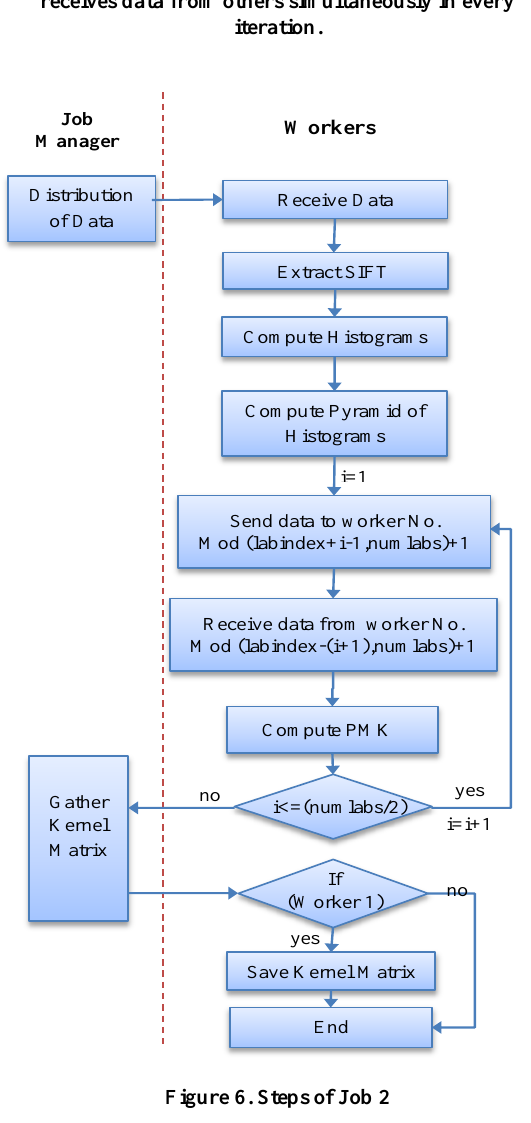
Figure 6. Steps of Job